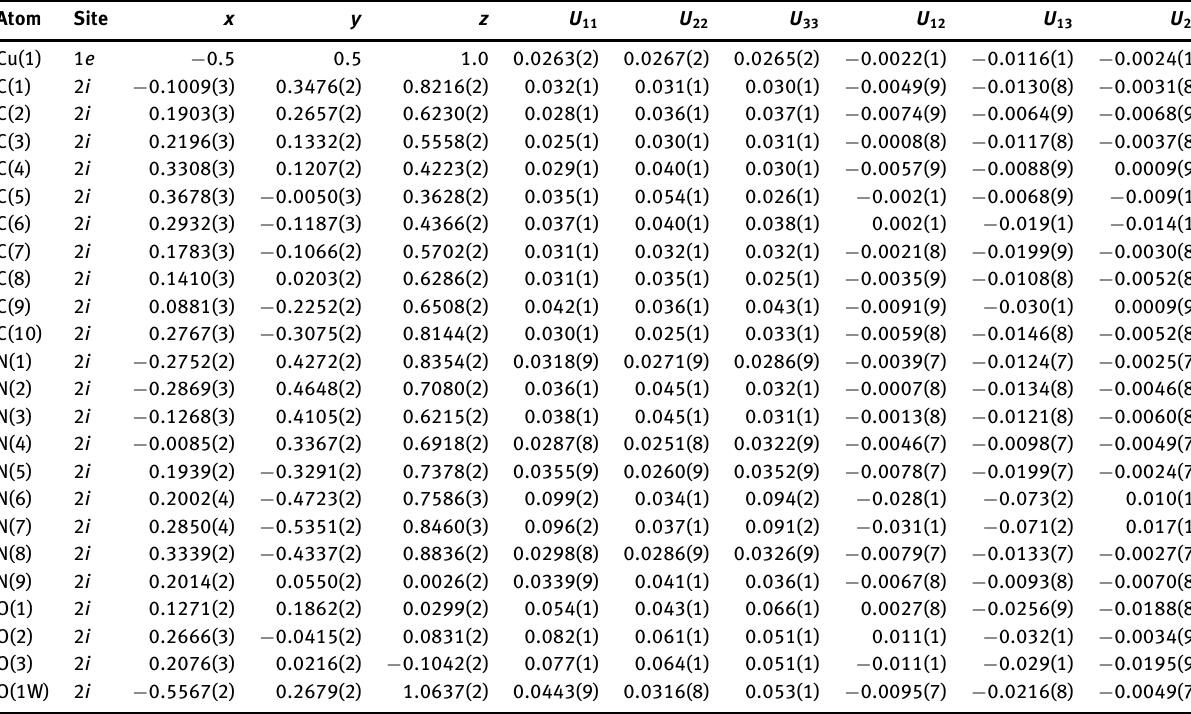
Table 3: Atomic displacement parameters (Å 2